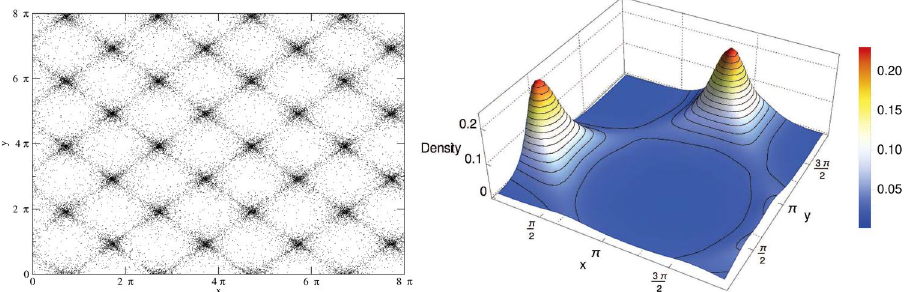
Figure 1. (left) Periodic Bravais-like structure in the mixed attractive/repulsive 2 D -HMF model. A flux of particles is hopping from one core to another for the energy density H / N close to − 0.5. The parameters were fixed to c = − 1 and d = 1 in Eq. (5). (right) Space distribution of the particle density in an elementary [0:2 π ] × [0:2 π ]